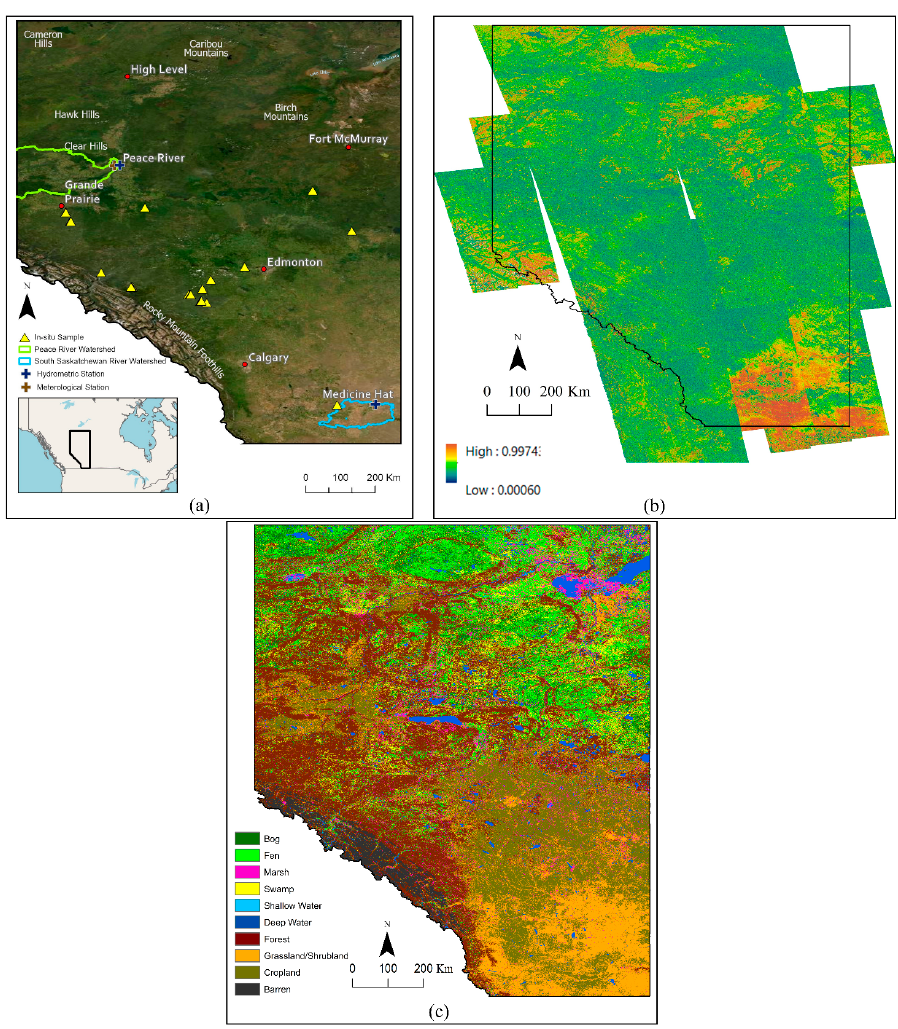
Figure 1. ( a ) Study area (Alberta) and the distribution of in situ samples and the locations of the hydrological and meteorological stations; ( b ) an example of a coherence map from the province of Alberta produced in Ref. [30]; ( c ) Alberta-wide wetland map produced in Ref. [33].